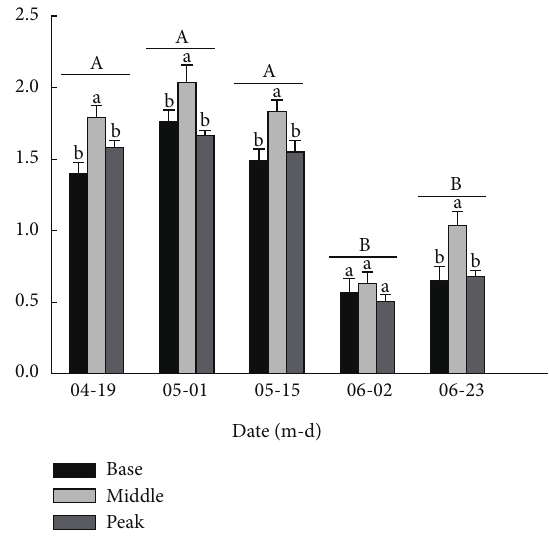
Figure 2: The comparison of the soil moisture content of three locations at different sampling dates (% ± S.E). Different lowercase letters indicate a significant difference among locations at the same sampling date and at the same soil depth ( 𝑃 < 0.05 ). Different uppercase letters indicate a significant difference between different sampling dates at the same soil depth and at the same